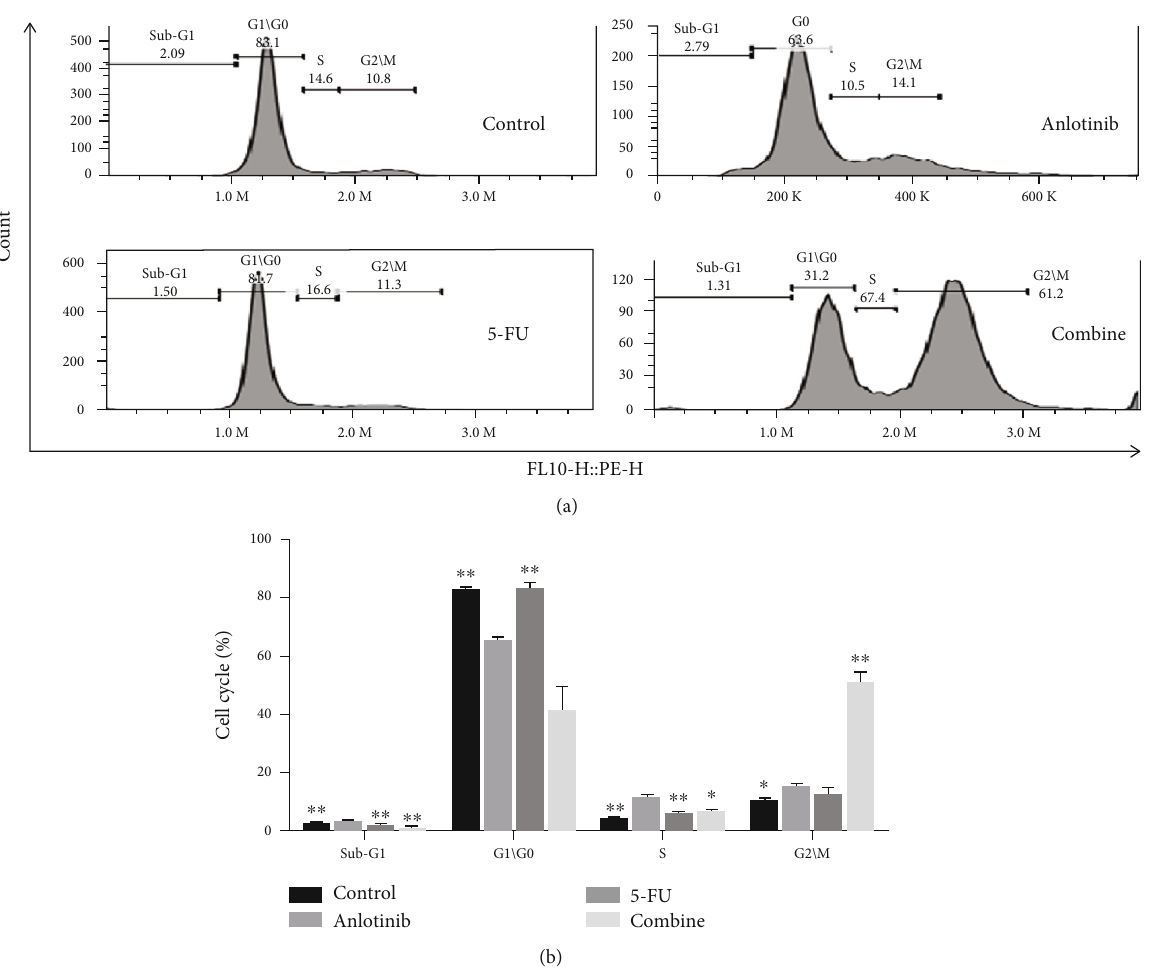
Figure 3: Anlotinib combined with 5-FU induced cell cycle arrest in the H446 cells using cell cycle kit. (a) The H446 cells were treatment with anlotinib (5 μ M) and 5-FU (10 μ M) or combination of both for 24 h. (b) The cell cycle rate (%) including G1\G0, S and G2\M. All experiments were repeated three times. The bars represent mean ± SEM of the three independent experiments. ∗ P < 0 : 05 and ∗∗ P < 0 : 01 compared with